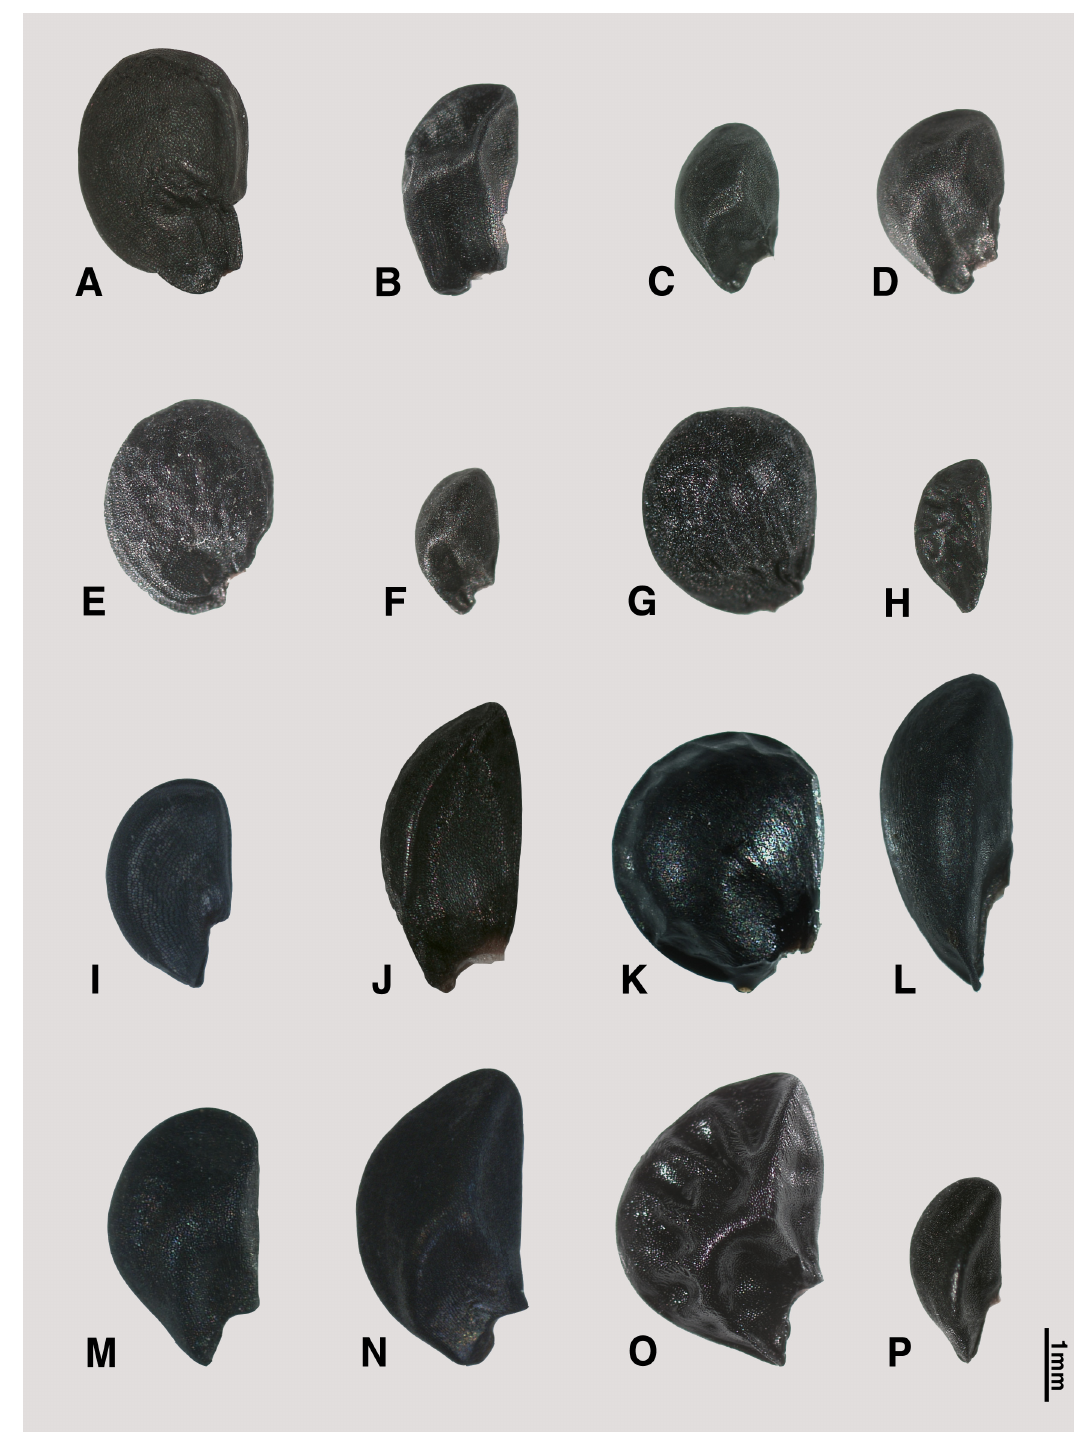
Figure 1. Various shapes of seed in Allium . ( A – I ) subg. Allium : ( A ) A. filidens (sect. Allium ); ( B ) A. caesium “101a”; ( C ) A. caesium “101b”; ( D ) A. caeruleum ; ( E ) A. svetlanae ; ( F ) A. tatyanae (sect. Caerulea ); ( G ) A. turkestanicum (sect. Mediasia ); ( H ) A. anisotepalum (sect. Minuta ); ( I ) A. pallasii (sect. Pallasia ); ( J , K ) subg. Butomissa : ( J ) A. oeroprasum (sect. Austromotana ); ( K ) A. ramosum (sect. Butomissa ); ( L – P ) subg. Cepa : ( L ) A. fedschenkoanum (sect. Annuloprason ); ( M ) A. altaicum ; ( N ) A. galanthum ; ( O ) A. oschaninii (sect. Cepa ); ( P ) A. maximowiczii (sect. Schoenoprasum